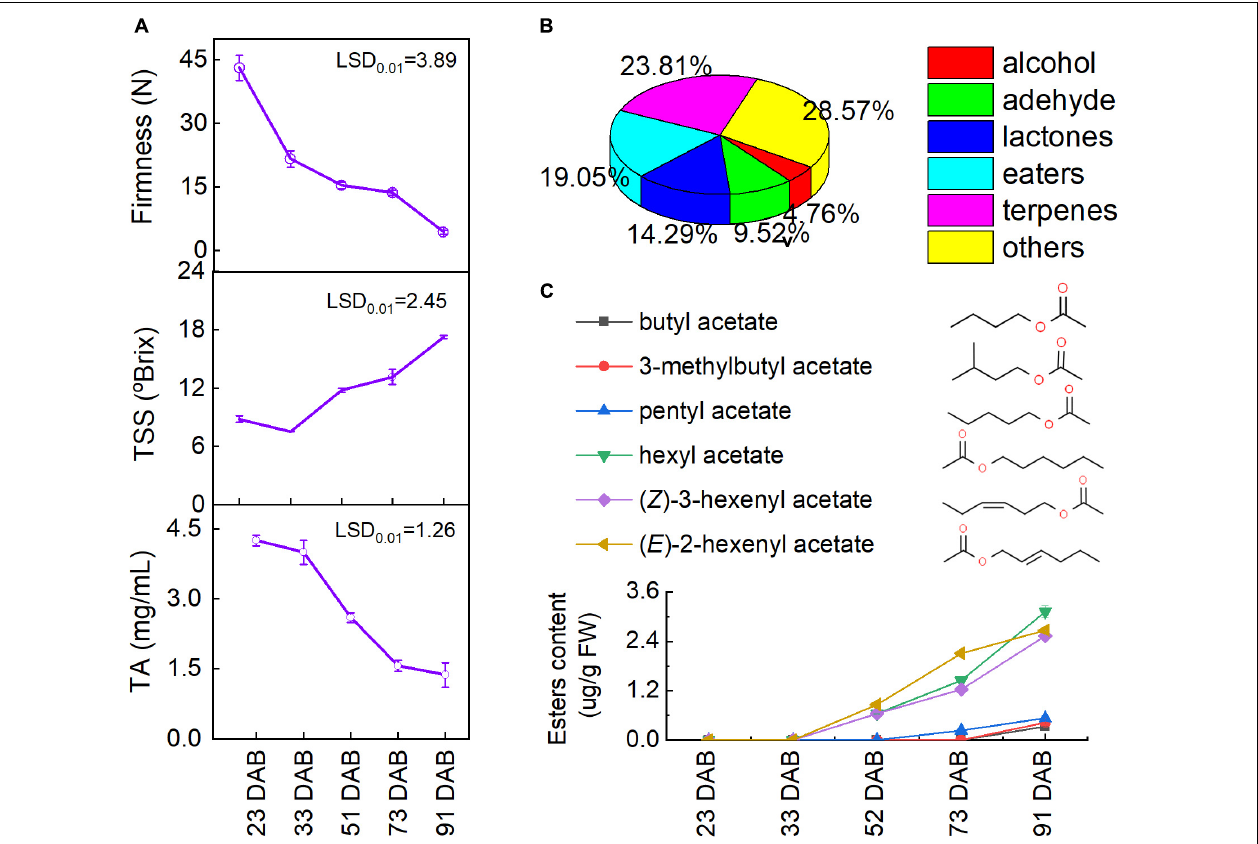
FIGURE 3 | Changes in volatile esters during fruit ripening: (A) fruit firmness, fruit weight, total soluble solids (TSS), and titratable acid (TA) contents; (B) ratio of all volatiles and (C) esters. LSD, least significant difference ( p < 0.01).